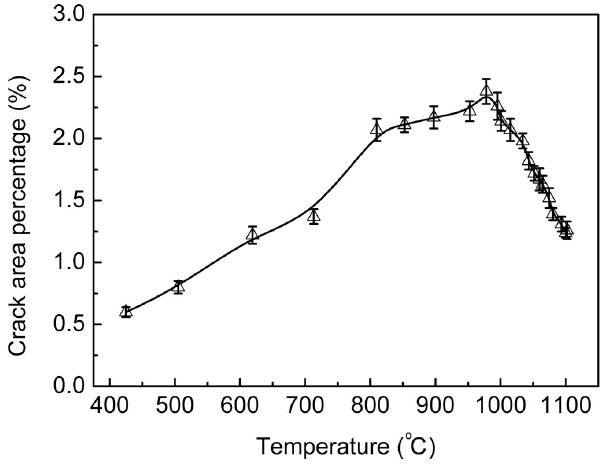
2 O 3 film with the increase of temperature.